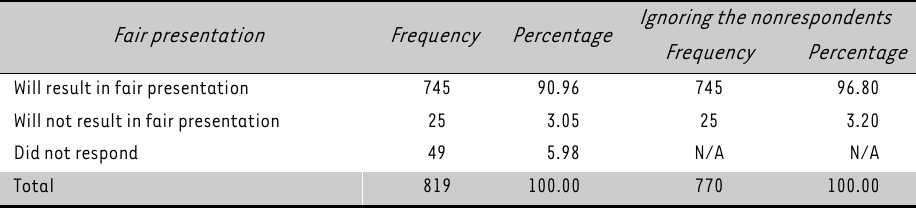
Will micro GAAP represent fair